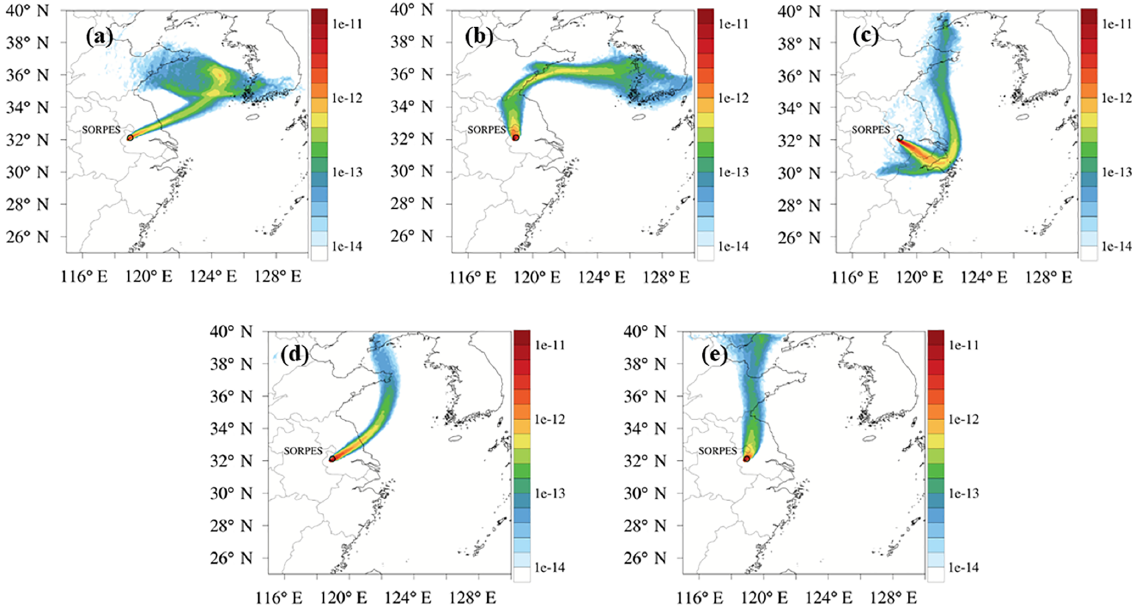
Figure 6. The averaged retroplume (footprint residence time) from 09:00 to 15:00LT on (a) 22 September, (b) 24 September, (c) 26 Septem- ber, (d) 4 October, and (e) 6 October 2014.